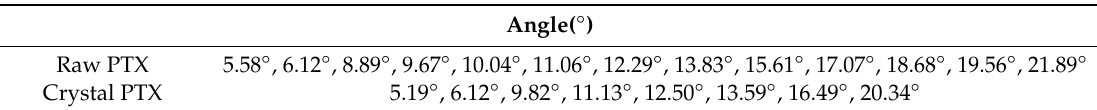
Figure 7. XRD patterns (2 θ = 4–50°) of the samples. ( a ) Raw PTX; and ( b ) PTX crystal powders.